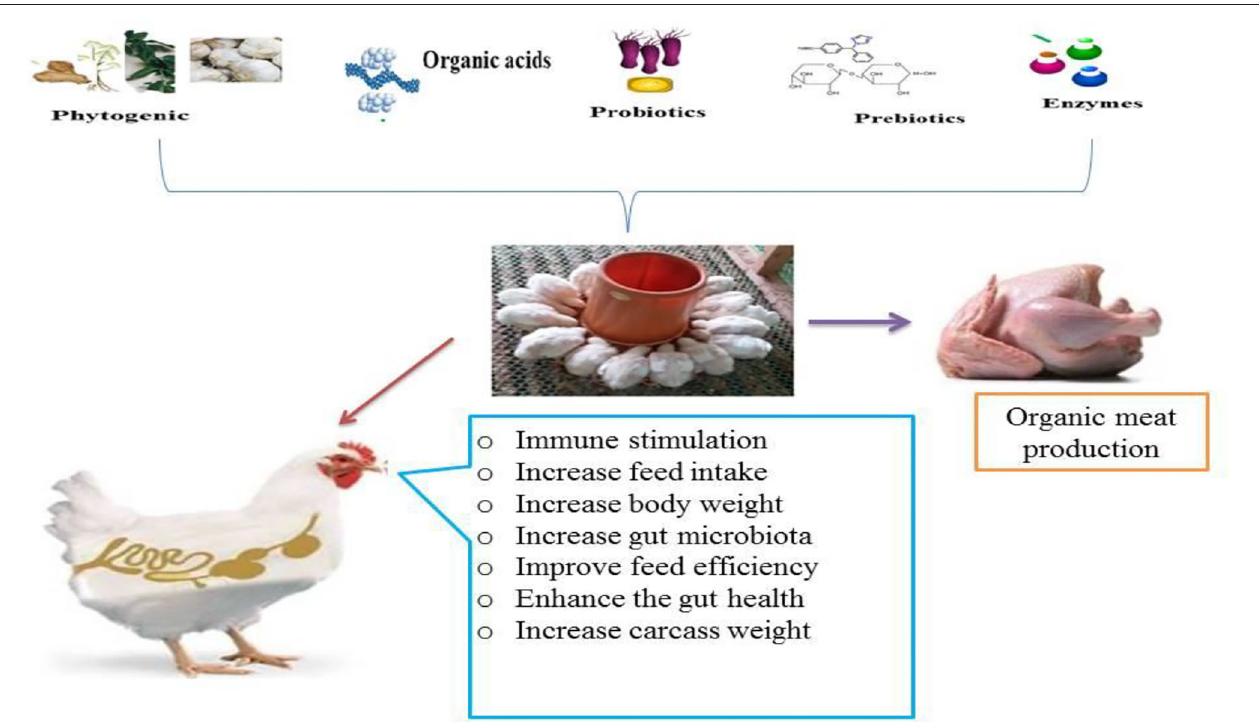
FIGURE 1 | Schematic diagram of an alternative feed additive in broiler